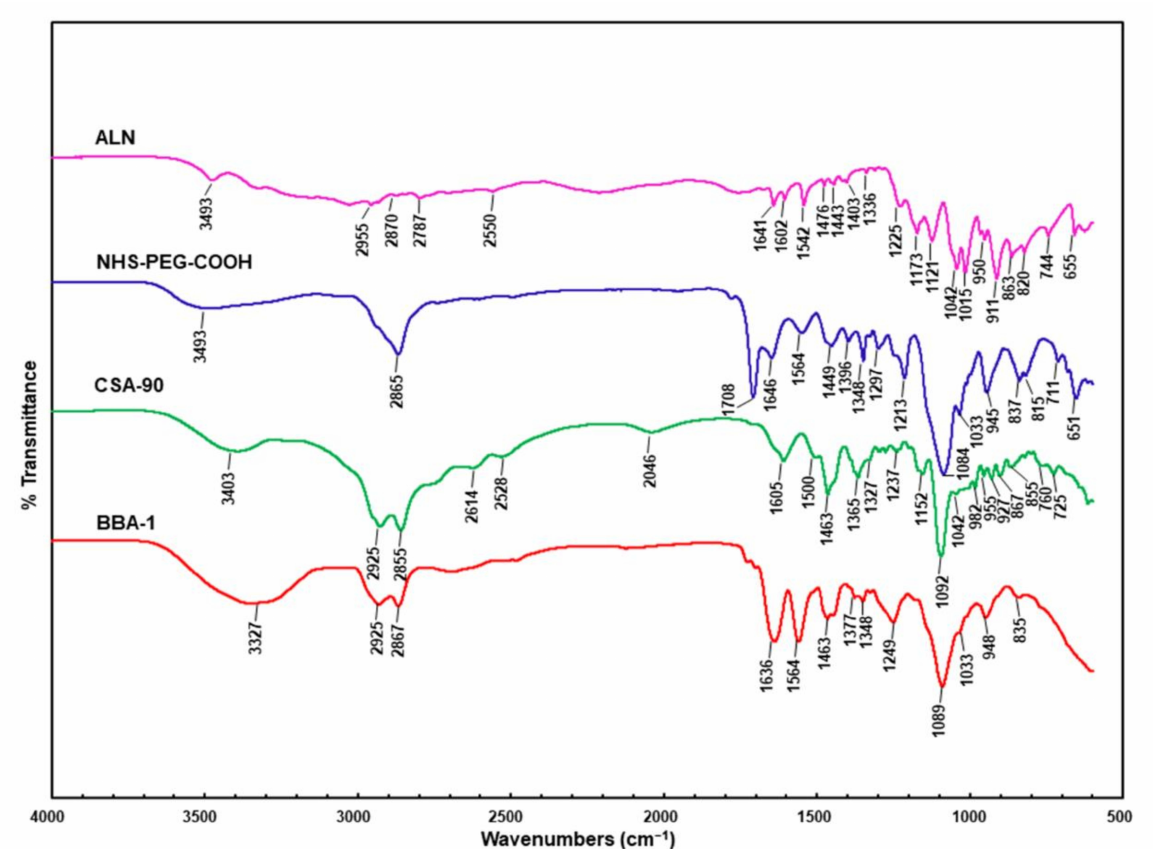
Figure 3. FT-IR spectra of ALN, NHS-PEG-COOH, CSA-90 and BBA-1. Formation of BBA-1 is indicated by the presence of a typical carbonyl group at 1636 cm − 1 due to the stretching vibration of the amide formed after alendronate and CSA-90